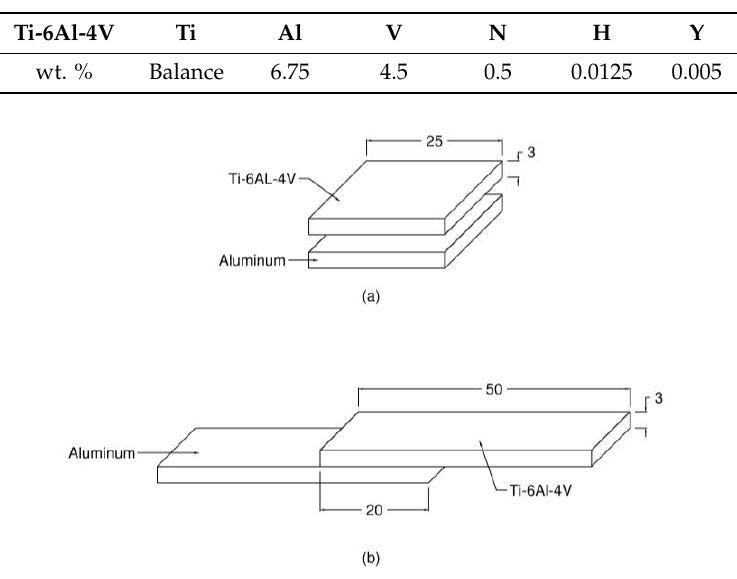
Figure 1. Dimensions of test samples for ( a ) SEM and microhardness ( b ) tensile test (All dimensions are in mm).